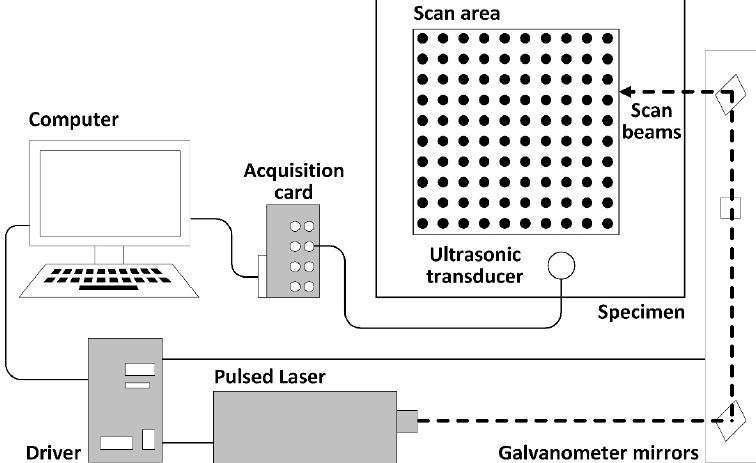
Figure 2. A schematic diagram of the laser ultrasonic inspection system configuration, including the pulsed laser, galvanometer mirrors, acquisition card, and ultrasonic transducer.